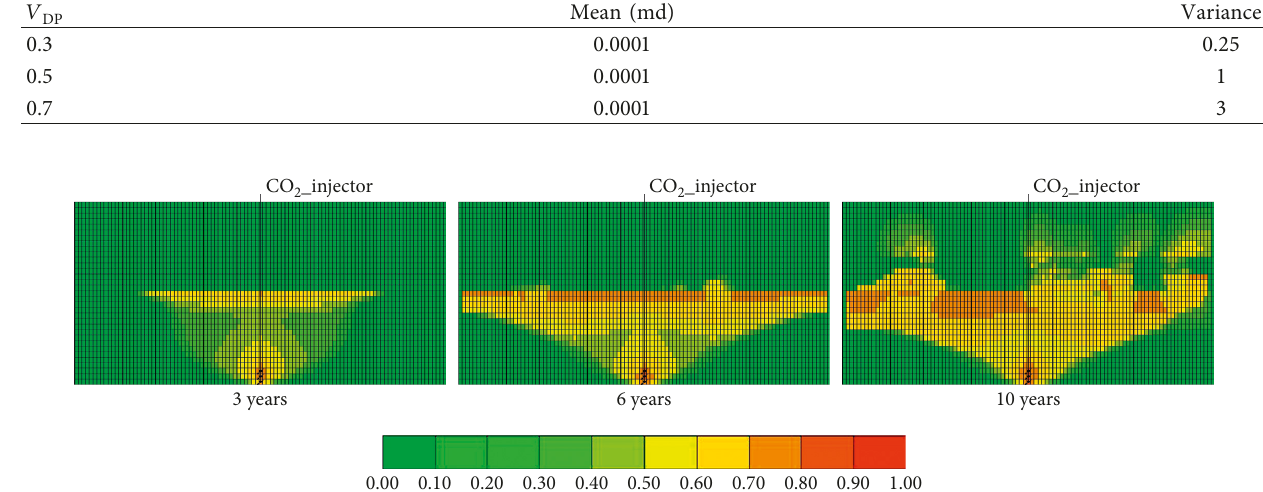
� 0.7 and Case C. DP